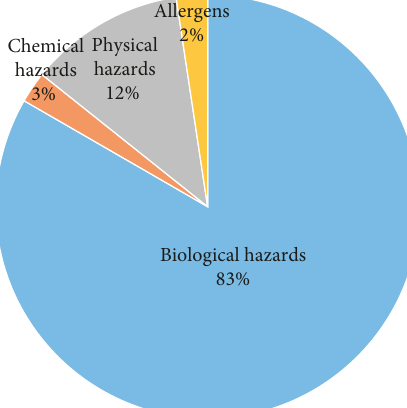
Figure 2: The most critical hazard in Ga kenkey production during Ga kenkey production.